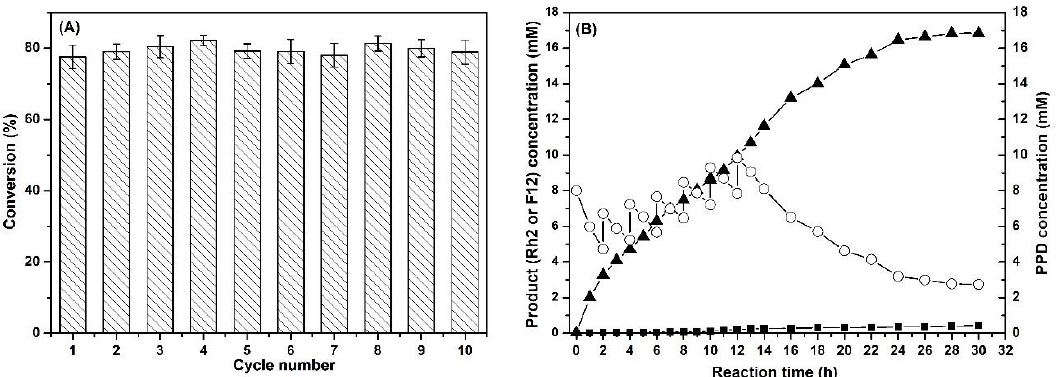
Figure 5. Reusability of the co-immobilized M315F and At SuSy for Rh2 production ( A ). Fed-batch biosynthesis of ginseno- side Rh2 by co-immobilized M315F and At SuSy coupled reaction ( B ), and PPD ( ○ ), product of ginsenoside Rh2 ( ▲ ), prod- uct of ginsenoside F12 ( ■ ) was measured.